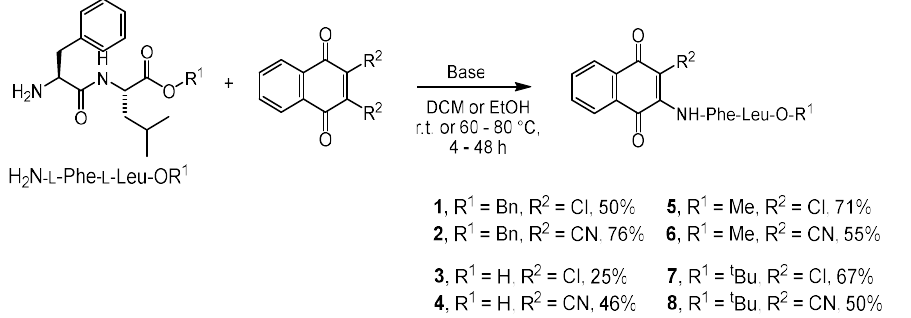
Scheme 1. Syntheses of potential protease inhibitors with naphthoquinone units as the reactive group.